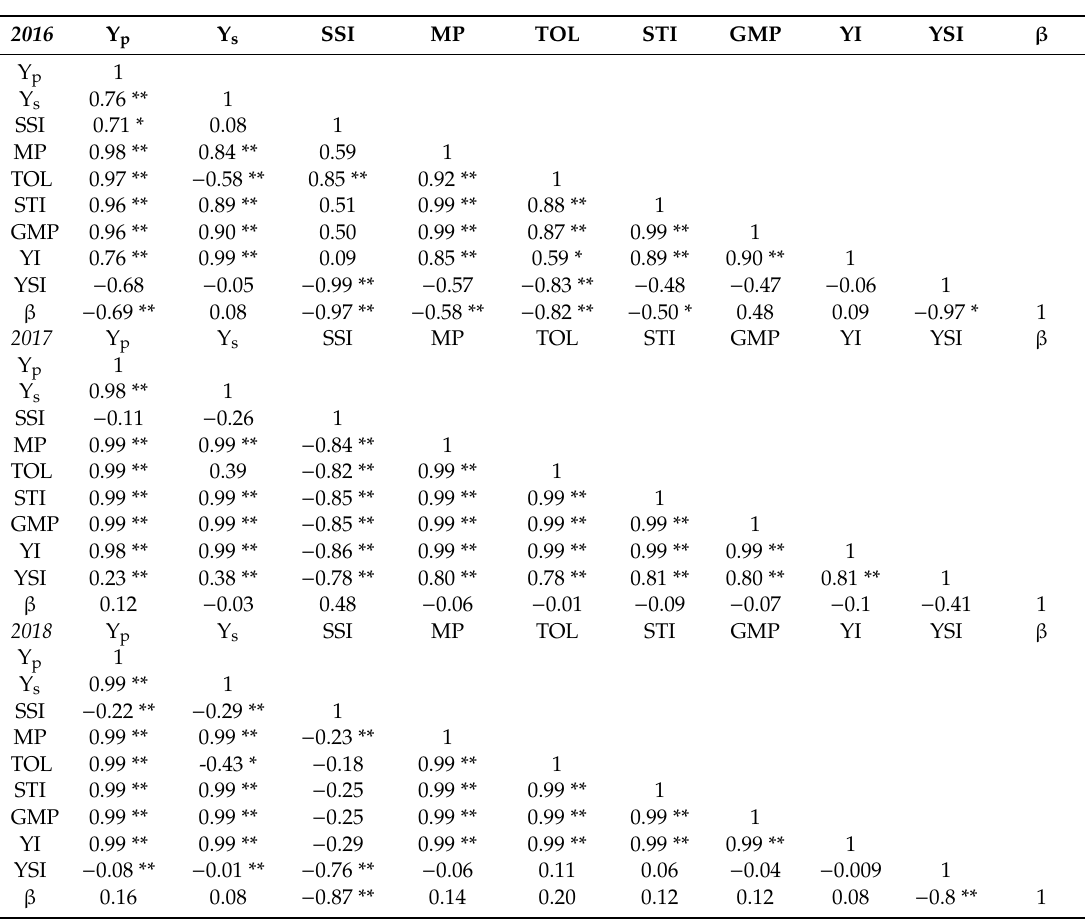
Table 4. Simple correlation coe ffi cients between Y p , Y s , and drought tolerance / susceptibility indices of genotypes in Kerman in three